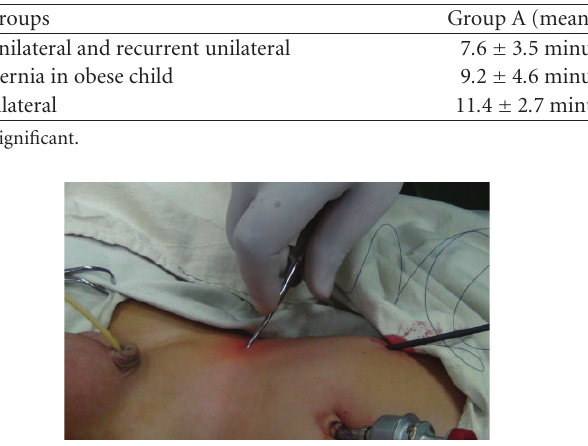
Figure 2: Insertion of RN on the right